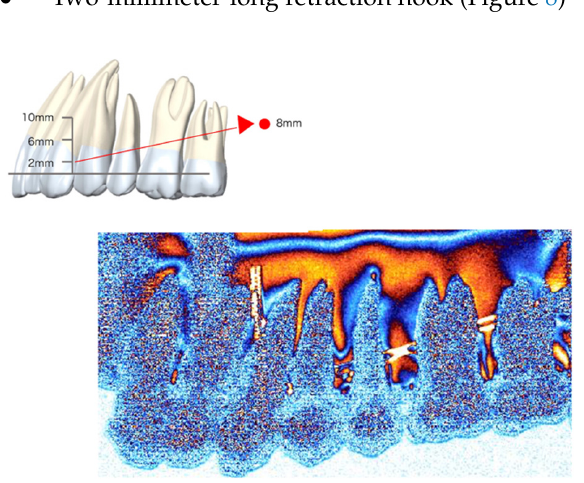
Figure 8. Two-millimeter retraction hook and 8 mm positioned posterior anchor mode.